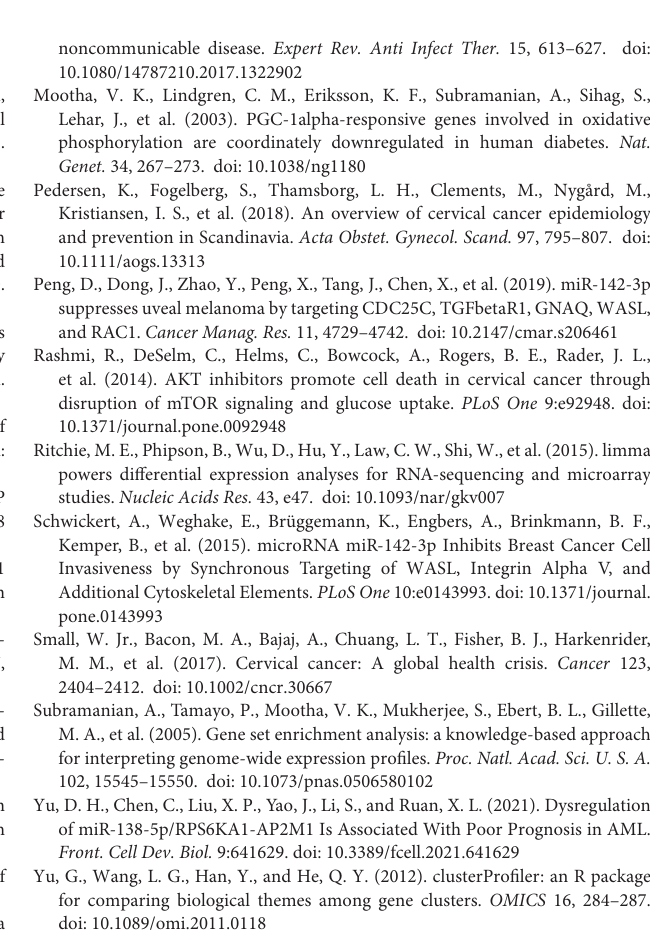
Supplementary Figure 1 | RT-PCR depicting the knockdown efficiency of WASL. Supplementary Table 1 | Differentially expressed genes between WASL knockdown group and normal control